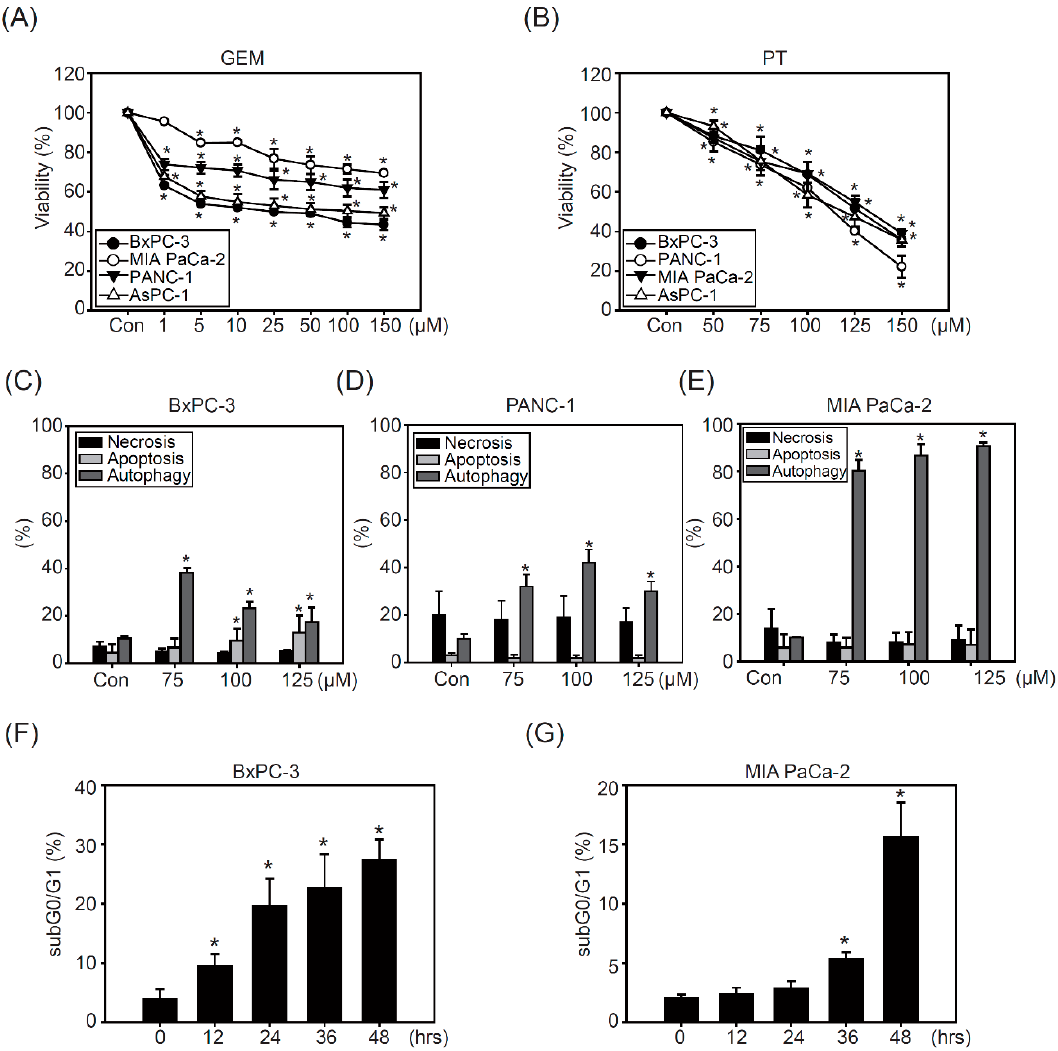
Figure 1. The cytotoxic effects of pterostilbene (PT) in pancreatic cancer cells: ( A ) Gemcitabine (GME) (0, 1, 5, 10, 25, 50, 100, and 150 µ M) and ( B ) pterostilbene (PT) (0, 50, 75, 100, 125, and 150 µ M) treatment on BxPC-3, PANC-1, AsPC-1, and MIA PaCa-2 cells for 48 h. Cell viability of four cell lines was analyzed via MTT assay. The data are presented as the mean ± SEM, n = 3. * p < 0.05 compared to the control (DMSO) groups. Necrosis, apoptosis, and autophagy analysis were performed via flow cytometry in ( C ) BxPC-3, ( D ) PANC-1, and ( E ) MIA PaCa-2 cells treated with PT in a concentration-dependent manner (0, 75, 100, and 125 µ M) for 48 h. Percentage of subG0/G1 was analyzed in ( F ) BxPc-3 and ( G ) MIA PaCa-2 cells treated with PT (100 µ M) for 0, 12, 24, 36, and 48 h, and then detected with propidium iodide (PI) staining and analyzed via flow cytometry. The data are presented as the mean ± SEM; n = 3. * p < 0.05 compared to the control (Con, DMSO) groups.